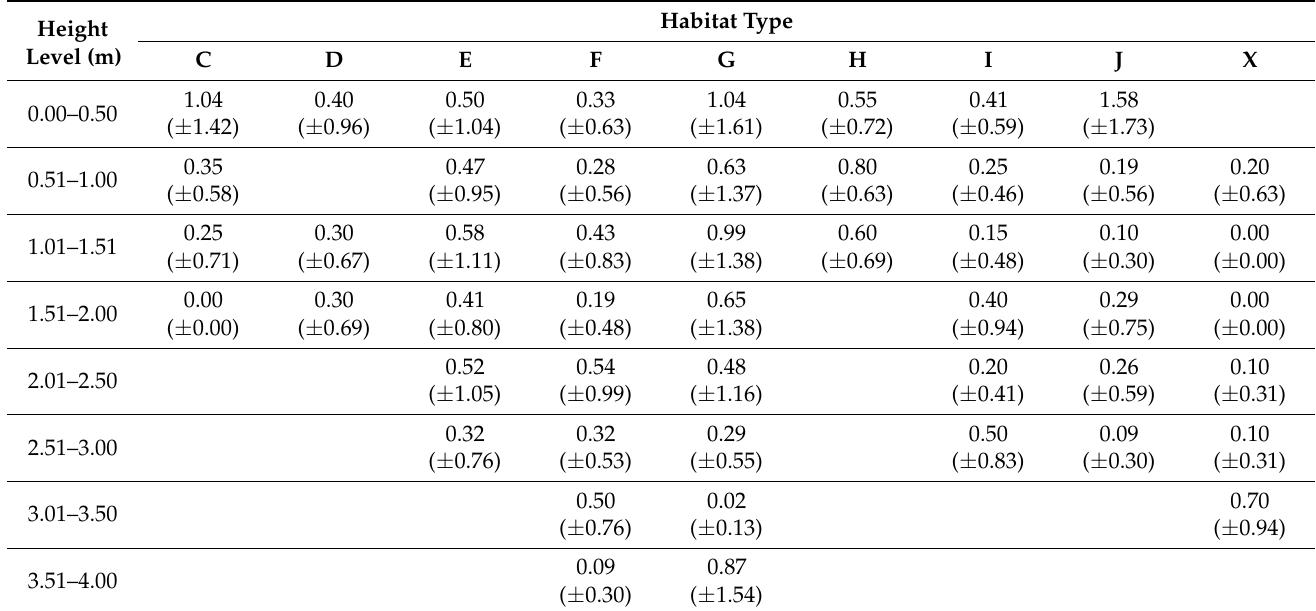
Table 10. The number of undeveloped seeds per fruit (mean ± SD) of Echinocystis lobata at different height levels in inland surface waters (C); mires, bogs, and fens (D); grasslands and lands dominated by forbs, mosses, or lichens (E); heathland, scrub, and tundra (F); woodland, forest, and other wooded land (G); inland unvegetated or sparsely vegetated habitats (H); regularly or recently cultivated agricultural, horticultural and domestic habitats (I); constructed, industrial, and other artificial habitats (J); habitat complexes